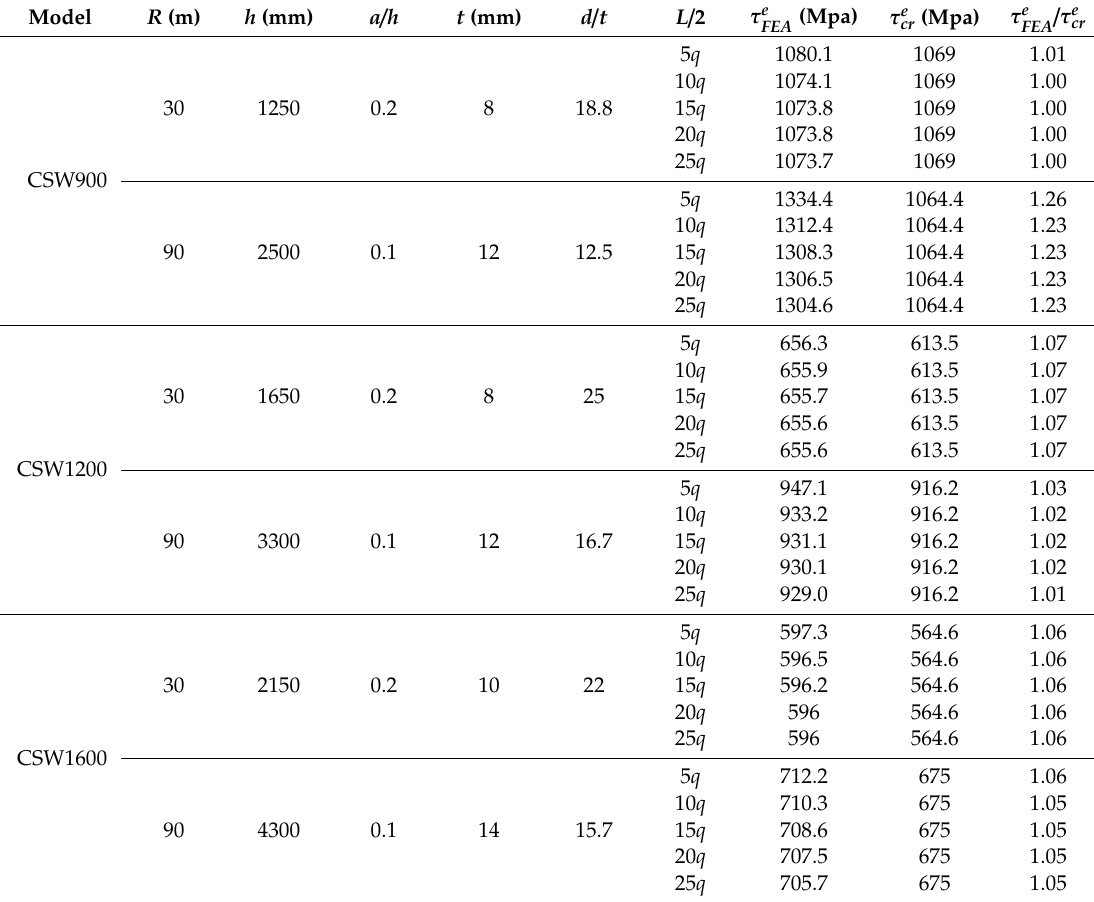
Table 10. Elastic shear buckling stress of CSWs for di ff erent spans.